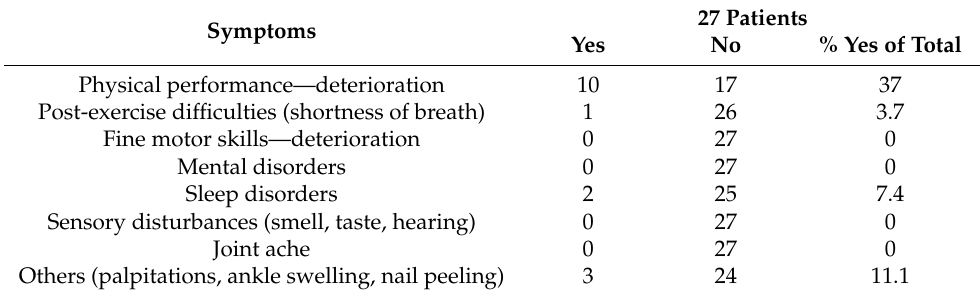
Table 3. Symptoms before and 3 months after